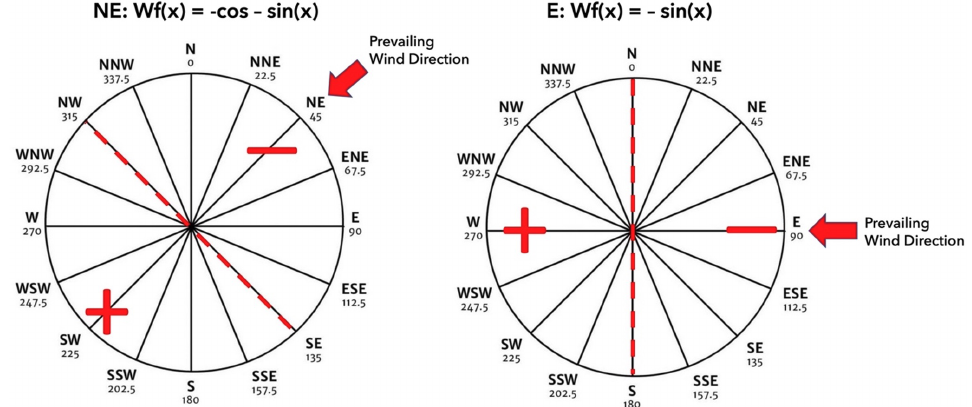
Figure A2. The prevailing wind directions (NE and E) calculated from meteorological station data and the corresponding wind equations applied in this study.